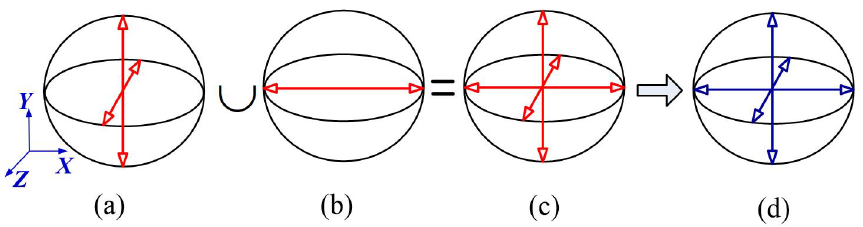
Figure 5. Constraint and DoF space graph of the whole manipulator: (a) PLMEs limb, (b) Single Loop 2-UPR, (c) Constraint space of moving platform, (d) DoF space of moving